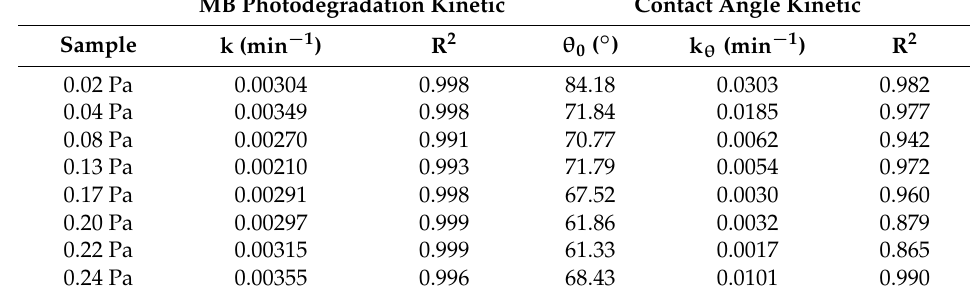
Table 3. MB photodegradation and contact angle kinetic parameters.